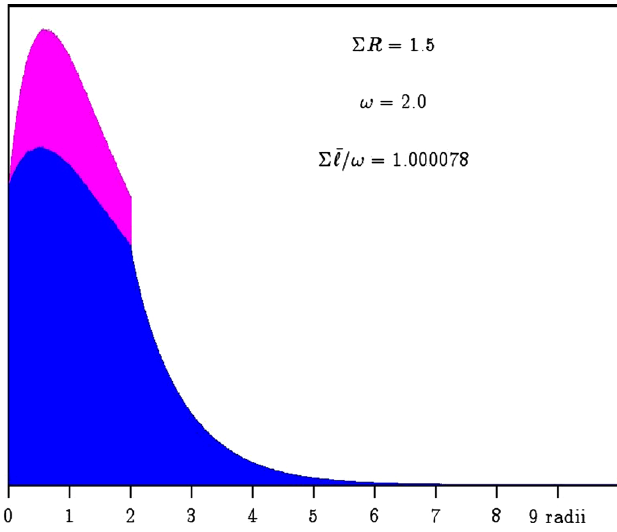
Fig. 4. Distribution of the lengths travelled by the particles for a sphere of opacity 2.